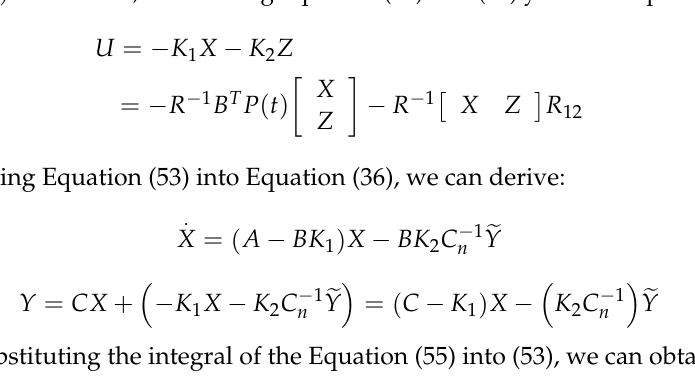
into the Equation